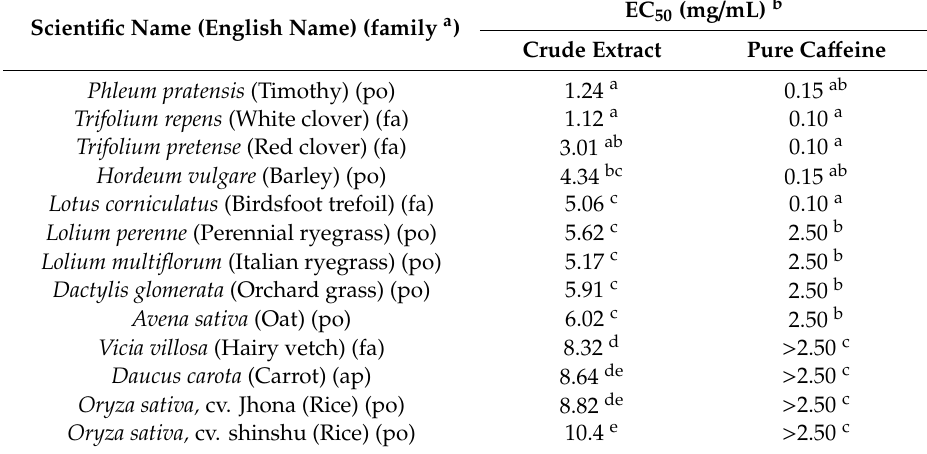
Table 3. E ff ect of Vinatea-green tea extraction and ca ff eine on radicle growth of the crop and selected weed